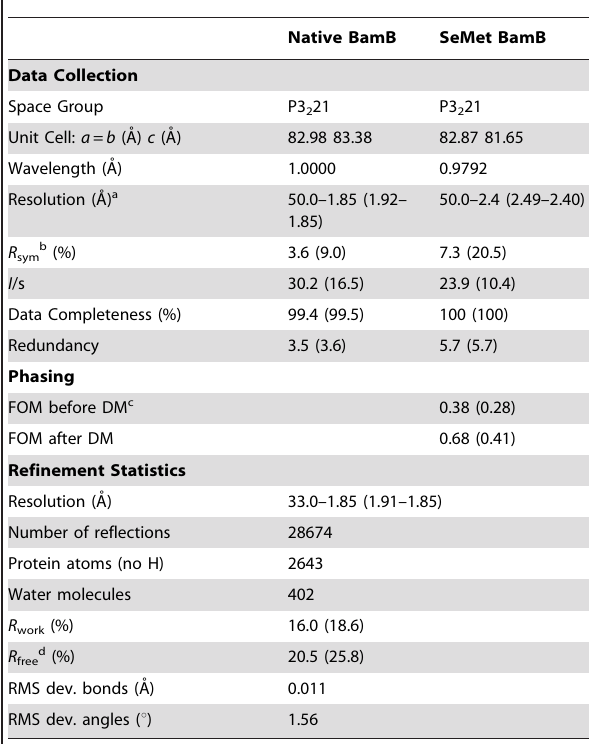
Table 1. Data Collection, Phasing and Refinement Statistics.